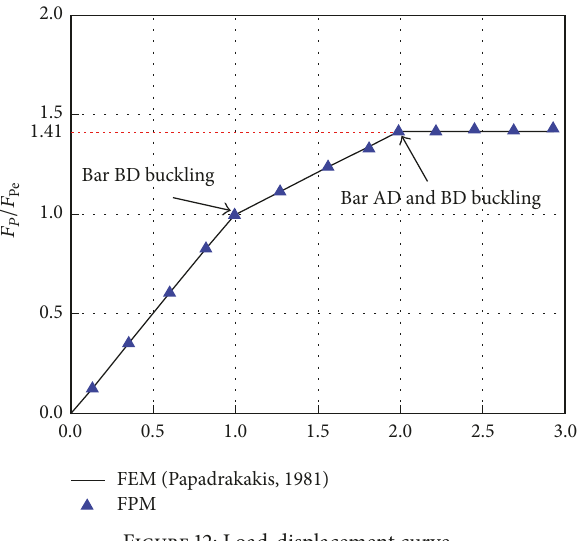
Figure 12: Load-displacement